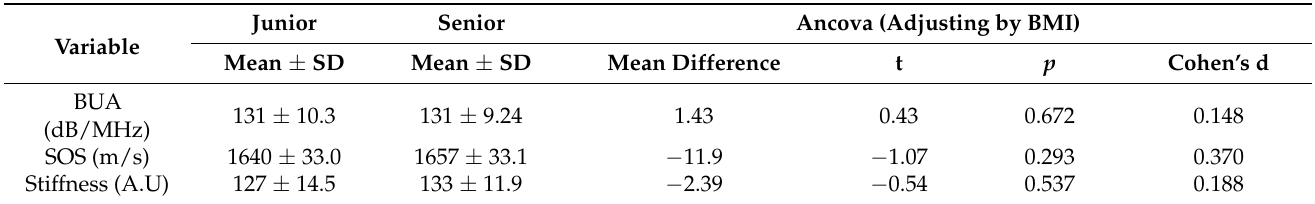
Table 3. Descriptive data on bone quality and differences between senior and junior.